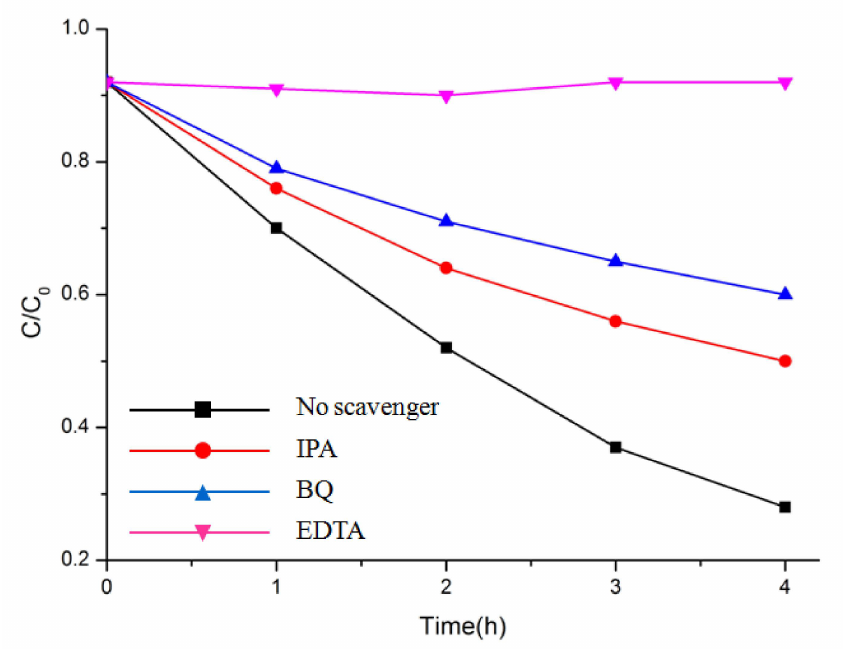
Figure 9. Photocatalytic degradation of MB over Bi 2 Mo 2 O 9 photocatalyst with the addition of scavengers EDTA, BQ, and IPA.